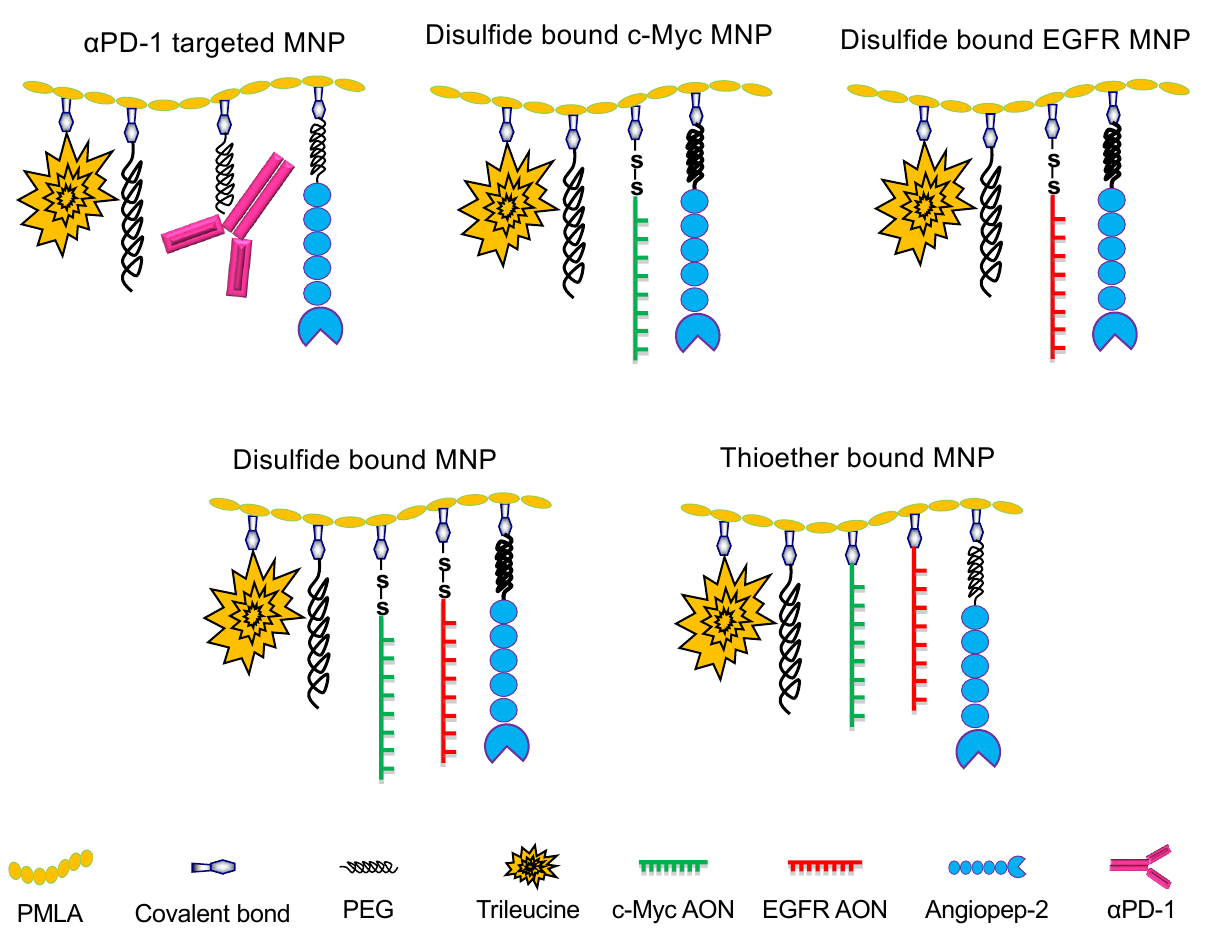
Figure 1. Schematic presentation of BBB crossing multifunctional nanoparticles (MNPs) to target c-Myc and EGFR, as well as α PD-1